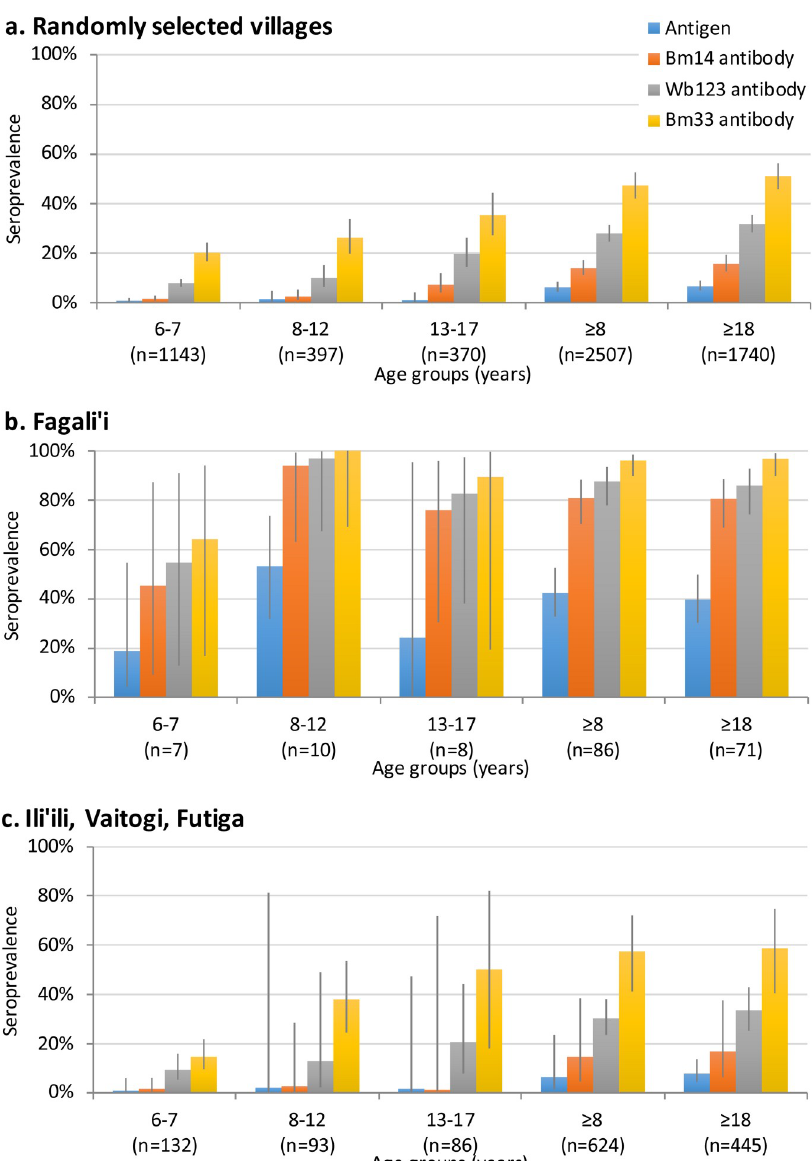
Fig 6. Adjusted seroprevalence (and 95% CI) of Ag and antibodies by age groups for a) randomly selected communities, b) Fagali’i, and c) Ili’ili/Vaitogi/Futiga. Tables 1 (for Ag and Mf) and 2 (for antibodies). For all seromarkers and Mf, both univariable and multivariable logistic regression showed that males, older age groups, and residents of Fagali’i were significantly more likely to be positive. While indoor workers were less likely to be positive, those who worked outdoors, at the tuna cannery and in other places were signifi- cantly positively associated with all seromarkers on univariable and multivariable analyses. Outdoor workers were more likely to be Mf-positive on univariable (but not multivariable) analyses, and other workers were more likely to be Mf-positive in both univariable and multi- variable analyses. Those who had travelled to an LF-endemic area in the past 12 months (96.2% to Samoa) were more likely to be seropositive for Bm33 antibody (but not the other